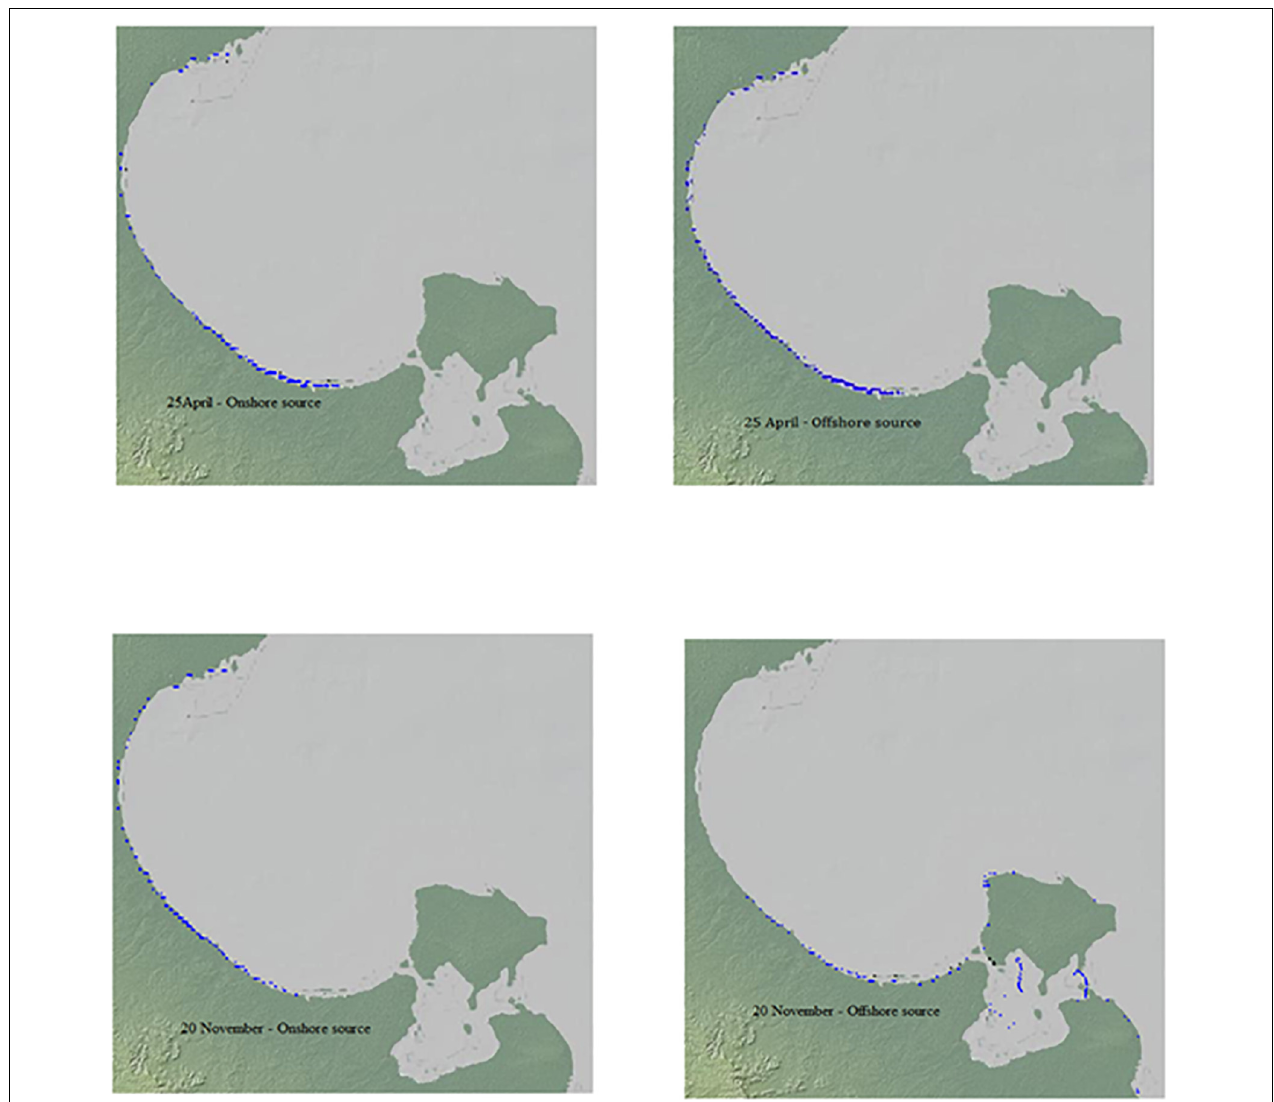
FIGURE 5 | Accumulation of virtual particles (blue points) coming from onshore and offshore virtual sources from numerical simulations after 2 months advection time in April and in November corresponding to the sampling period of the first and second campaign,